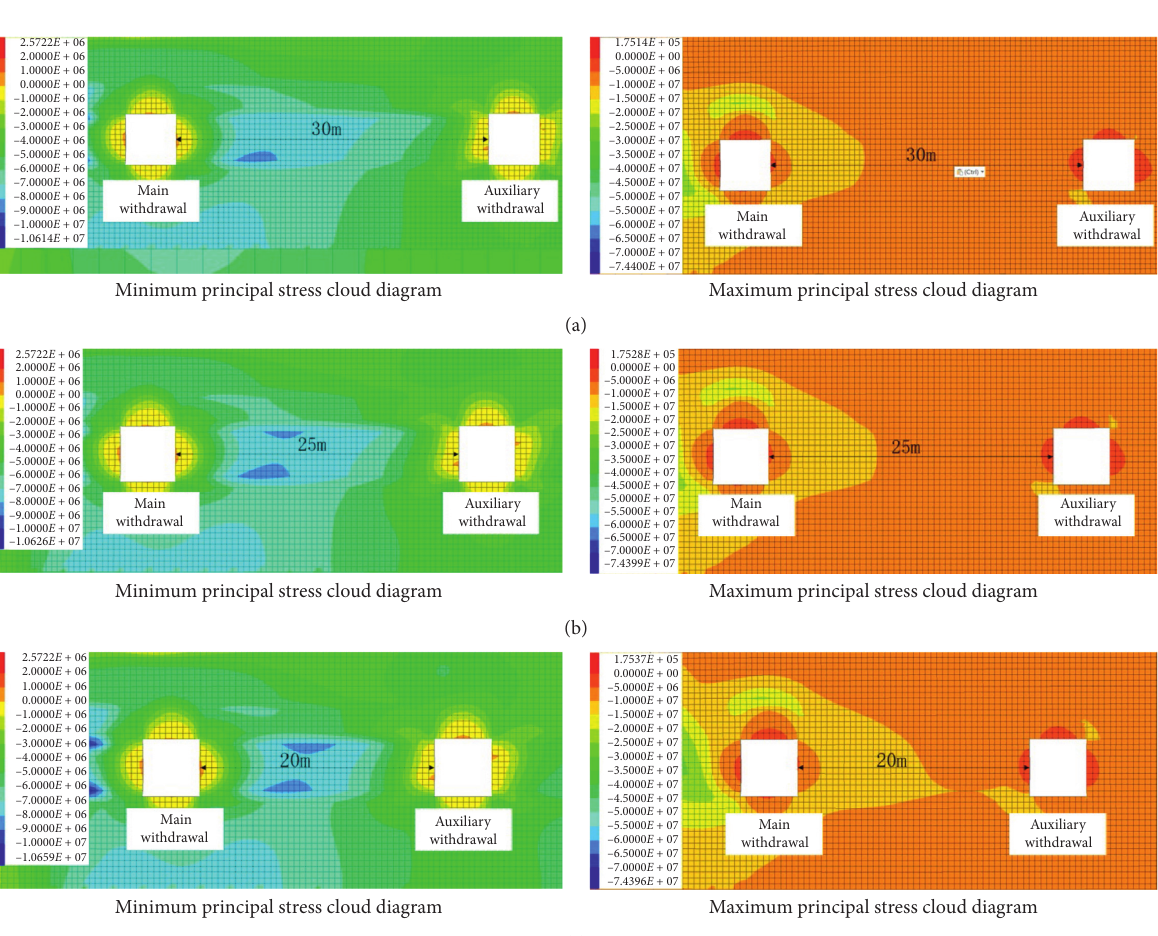
Figure 15: Maximum and minimum principal stress cloud diagrams when Panel 31113 is 10m from penetration. (a) When the main and auxiliary withdrawal spacing is 30m, (b) when the main and auxiliary withdrawal spacing is 25m, and (c) when the main and auxiliary withdrawal spacing is 20 m.